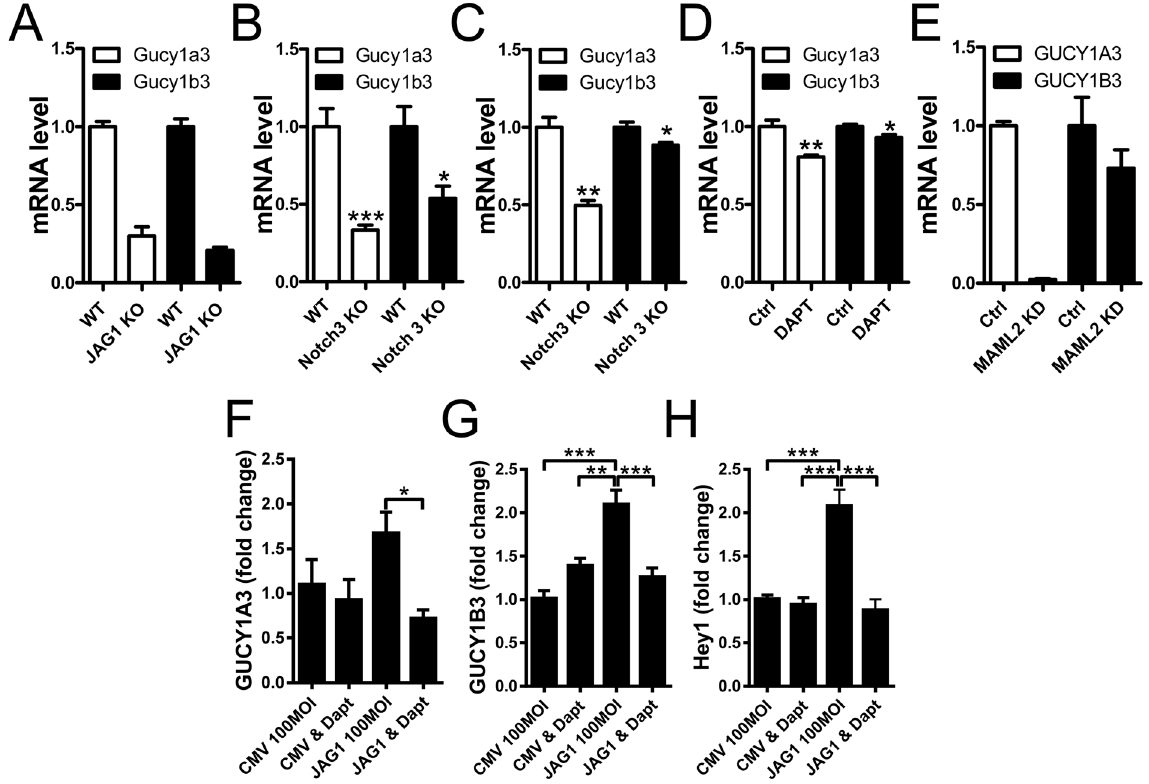
Figure 5. Genetic and pharmacological inhibition of Notch signaling leads to reduced Gucy1a3 / Gucy1b3 expression in smooth muscle. Transcriptomic data sets from knockout/knockdown models were analyzed for changes in sGC subunits. Panel A shows expression of sGC subunits in the 14.5 day embryonic aorta from Jag1 wild type (WT) and knockout (KO) mice as determined by deep sequencing (n = 2, and hence no statistical analysis performed). Panel B shows sGC expression in brain microvascular fragments from WT and Notch3 KO mice (n = 6), and panel C shows sGC expression in caudal arteries from Notch3 WT and KO mice (n = 3), both determined by microarray analysis. Panel D shows sGC expression as assessed using deep sequencing of RNA from smooth muscle cells isolated from the mouse descending aorta and treated with γ -secretase inhibitor (DAPT). Panel E shows sGC expression in parotid adenocarcinoma cells following retroviral-based knockdown of MAML2 (n = 2). In panels F through H human coronary artery smooth muscle cells were incubated with the γ -secretase inhibitor DAPT following treatment with Ad-CMV-null and Ad-CMV- JAG1 , respectively. sGC expression was determined using qRT-PCR. n = 6/group * P < 0.05, ** P < 0.01, P <